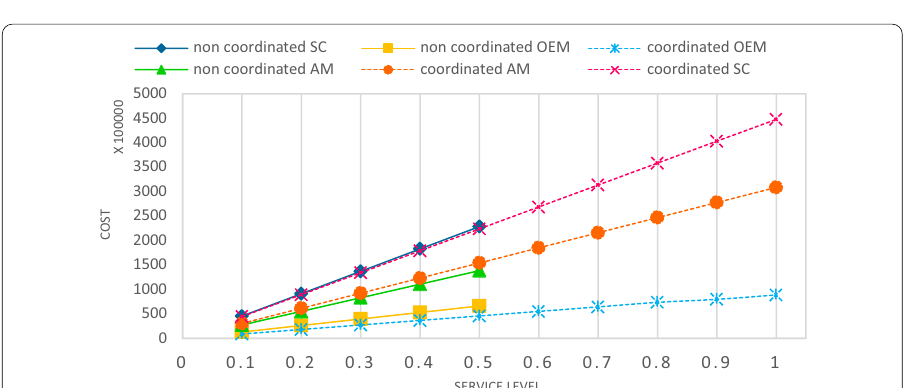
Fig. 3 The differences between the costs of OEM, AM, and the supply chain in two scenarios for different service levels. Note : For the service levels more than 0.5, the problem is infeasible for the